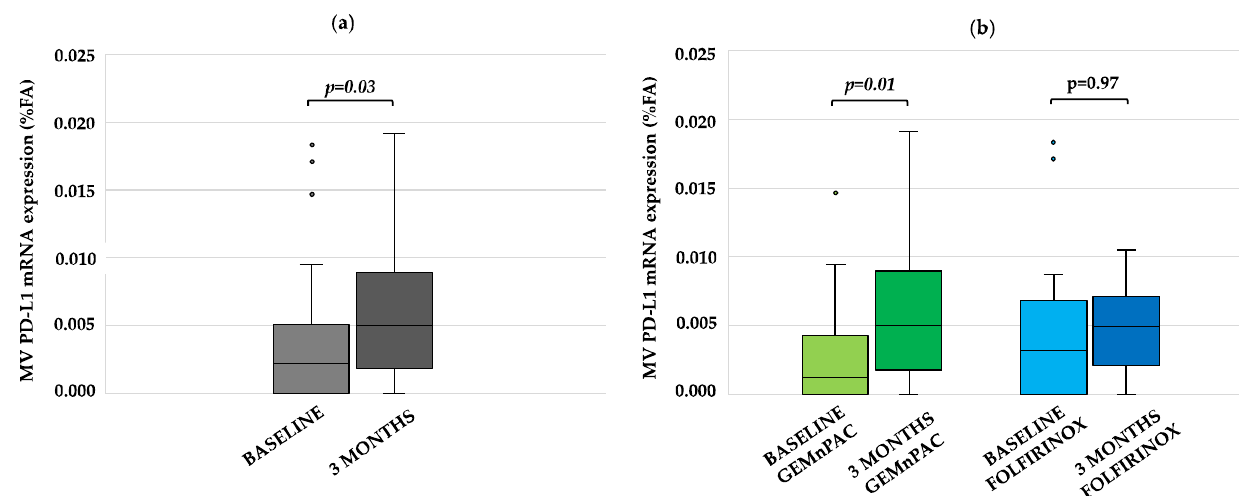
Figure 1. Effect of chemotherapy on PD-L1 mRNA levels in pancreatic cancer. ( a ) PD-L1 mRNA expression evaluated at baseline (light grey) and at tumor re-assessment after 3 months of treatment (dark grey), in the overall population; ( b ) differences in PD-L1 mRNA expression between baseline (light green and blue) vs. 3 months (dark green and blue) in patients grouped according to chemotherapy regimen (GEMnPAC vs. FOLFIRINOX). p values are reported on top of the bar chart. Abbreviations: PD-L1, programmed death-ligand 1; FA, fractional abundance.